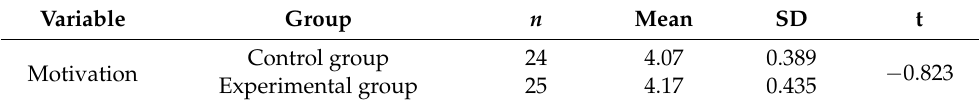
Table 1. Learning motivation among students in the control and experimental arms of the study.